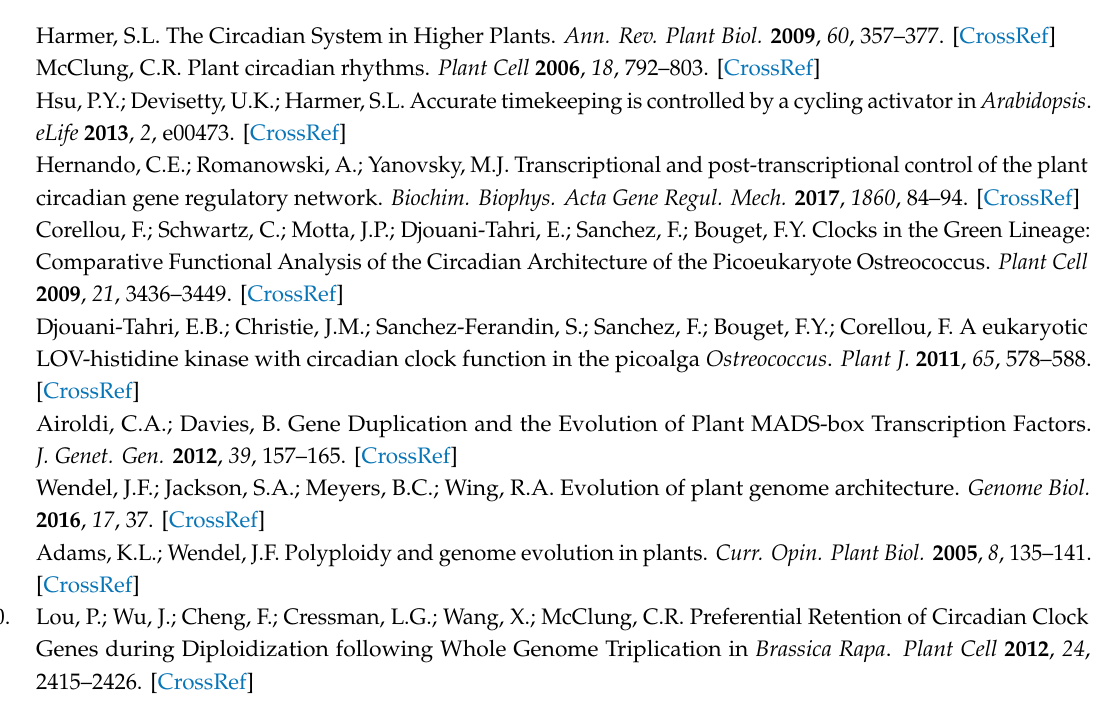
Figure S1: Metl or dissociation curve analysis of petunia genes, Figure S2: Exon-intron structure of Petunia axillaris (PaxiN) PRR5 and PRR7 genes, Figure S3: Domain structure of PSEUDO-RESPONSE REGULATORS (PRRs) , Figure S4: Local alignment of repression motifs of PRR5, Figure S5: Local alignment of GIGANTEA (GIs) proteins, Figure S6: Normalized expression (NE) for the biological replicates, Table S1: PSEUDO-RESPONSE REGULATORS (PRRs) protein accessions used in the phylogenetic reconstruction and for the annotation of protein sequences, Table S2: GIGANTEA (GI) protein accessions used in the phylogenetic reconstruction, Table S3: Primers used for